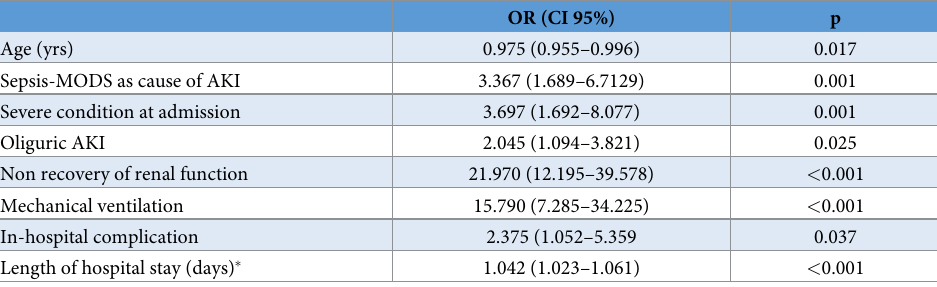
Table 2. Risk factors independently associated to in-hospital mortality. Multivariable logistic regression analysis. Variables entered in the model are those showed in Table